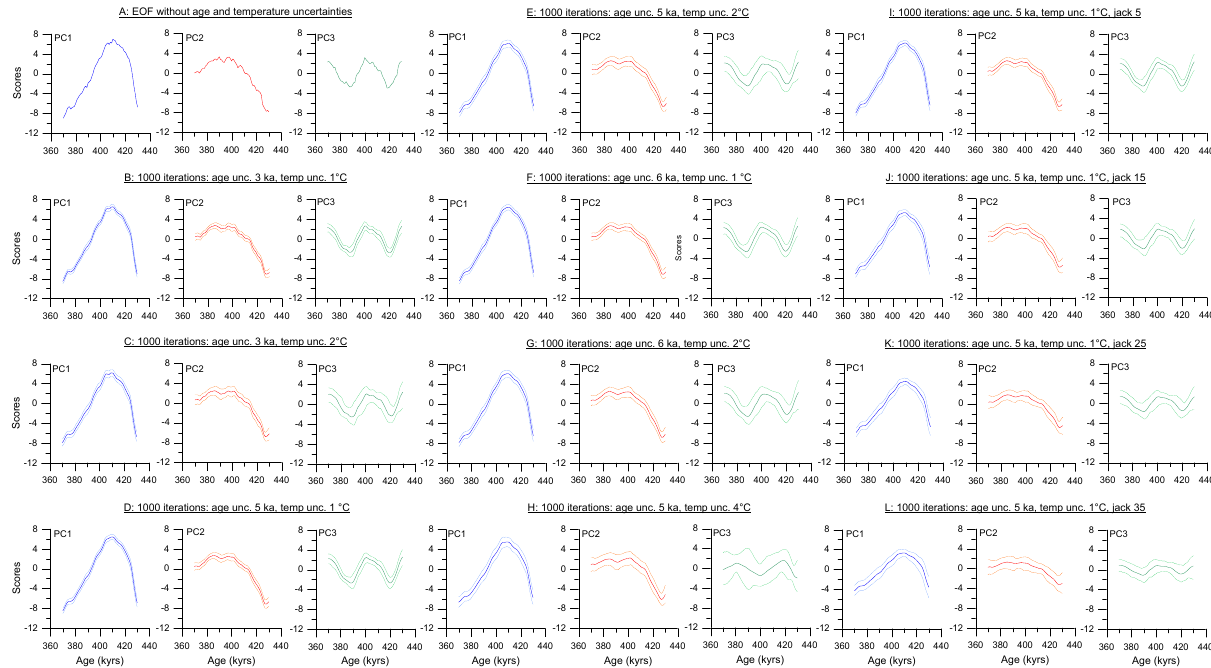
Fig. 4. Results of an empirical orthogonal function (EOF) analysis of MIS11 SST records (Fig. 1, Table 1), including results of a sensitiv- ity analysis with respect to age and temperature uncertainties. Re-calculations were made for age uncertainties of 3, 5 and 6kyr, and for temperature uncertainties of 1, 2 and 4 ◦ C. To test for sensitivity of the EOF to record selection, jackknifing was applied and 5, 15, 25 and 35 samples were randomly excluded from the data set (age and temperature uncertainties were set to 5kyr and 1 ◦ C). All calculations were made with 1000 iterations, and the confidence intervals are given for each analysis. For variances explained by the EOFs, see Table 3. Table 3. Variances explained by the first three empirical orthogonal functions (EOFs) of the MIS11 SST records, including 5 and 95% confidence limits (see also Fig. 4). Re-calculations were made with varying age and temperature uncertainties and a random exclusion of records (jackknifing, jack5 means that five records were excluded per replication). Control run refers to analysis of raw data without consideration of uncertainties. EOF results presented in Fig. 8 and discussed in Sect. 4.1 are given in bold.